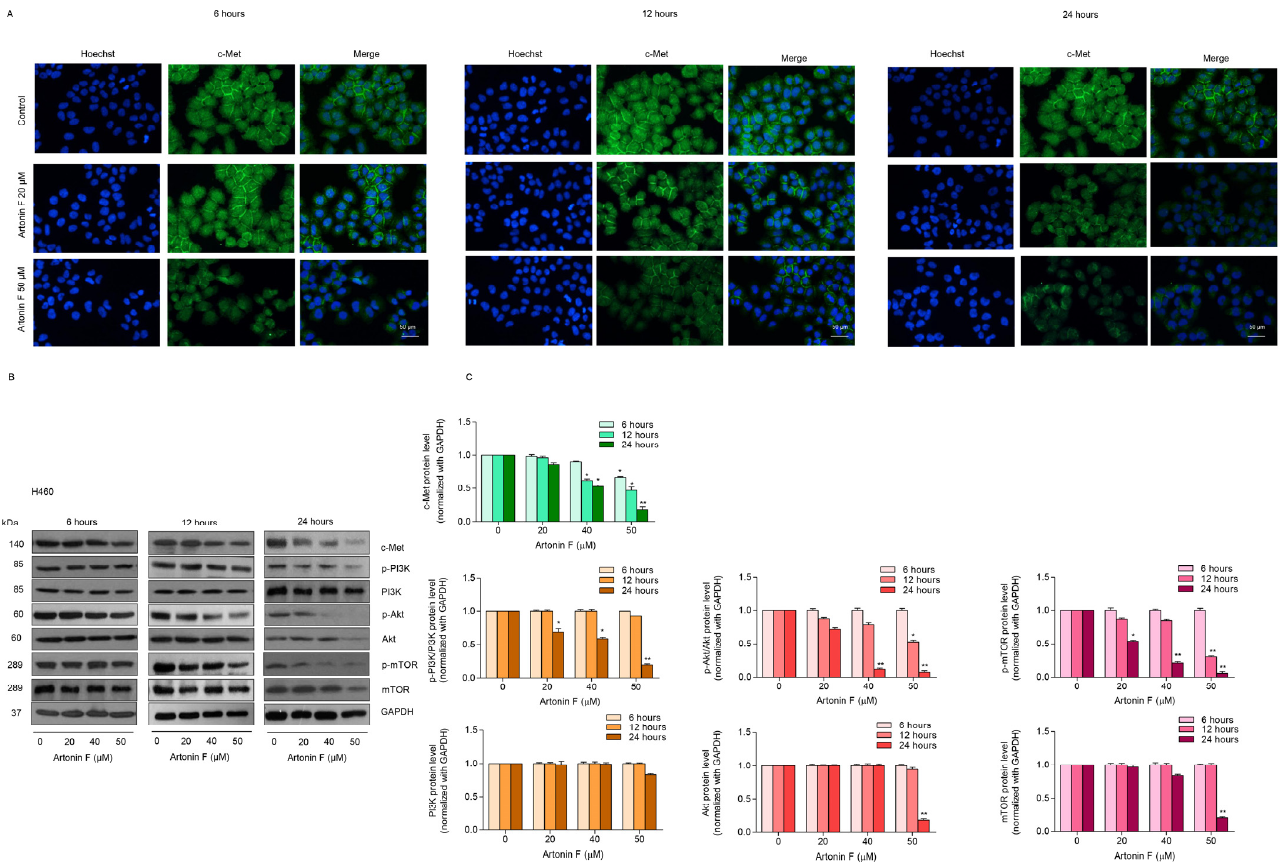
Figure 3. Artonin F causes a dramatic decrease in c-Met in the time-dependent analysis in the lung cancer cells. ( A ) Cells were stained with c-Met antibody (green fluorescence) and Hoechst 33342 (blue fluorescence). The expression of c-Met was determined by immunofluorescence. ( B , C ) The protein expressions were detected by Western blot. Blots were reprobed with GAPDH to confirm the equal loading of samples. The relative protein levels were calculated by densitometry. The relative protein levels were calculated by densitometry. Data are shown as the mean ± SEM ( n = 3). * p < 0.05, ** p < 0.01 versus the non-treated control.